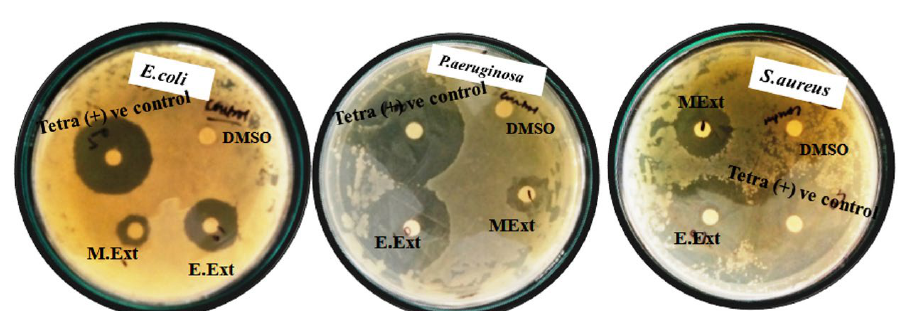
Fig. 4. Effect of temperature on growth of JRR34 (A) Streak plate at 4 °C (B) Streak plate at 25 °C (C) Streak plate at 37 °C